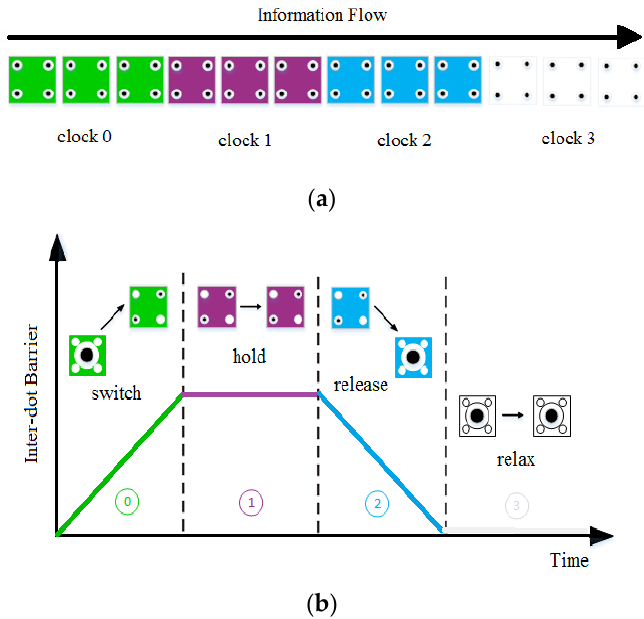
Figure 3 . ( a ) Clock phases and ( b ) QCA four-phase clock mechanism. Figure 3. ( a ) Clock phases and ( b ) QCA four-phase clock